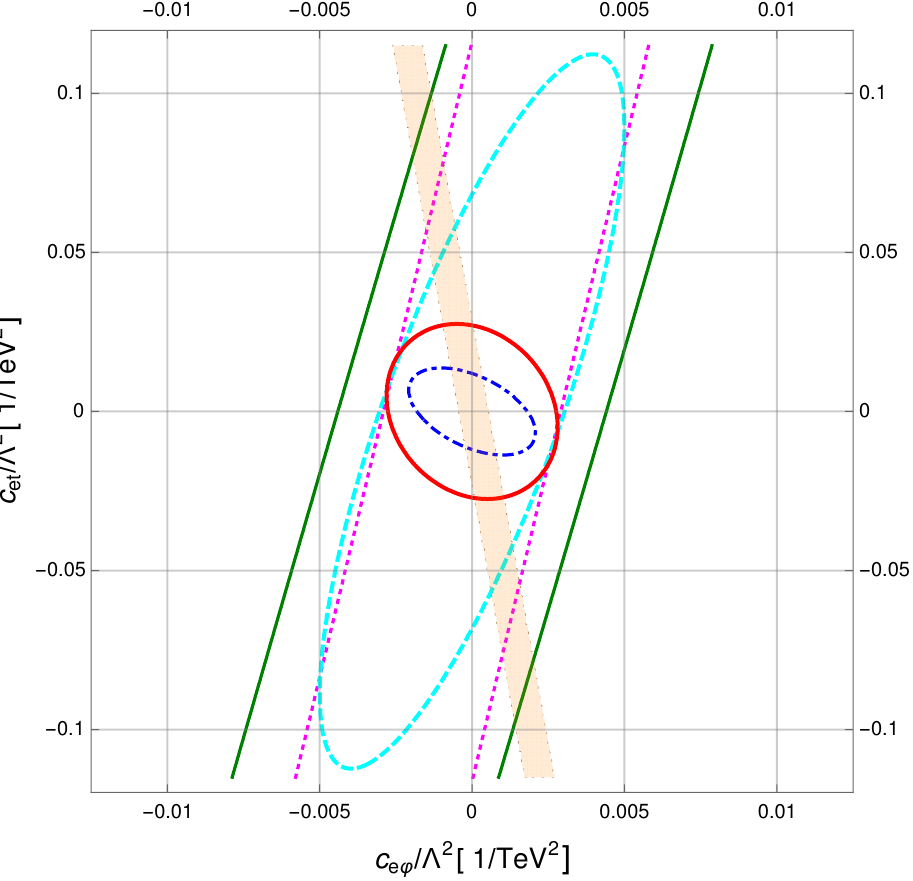
Figure 7. Exclusion regions in the ( c e’ = (cid:3) 2 ; c et = (cid:3) 2 ) plane for the di(cid:11)erent benchmark con(cid:12)gu- rations of energy and luminosity reported in table 1 in the case k = 1. Points that lie outside the ellipses are excluded at 95% CL. The light pink strip represents the expected exclusion region obtained from Higgs decay measurements at future lepton